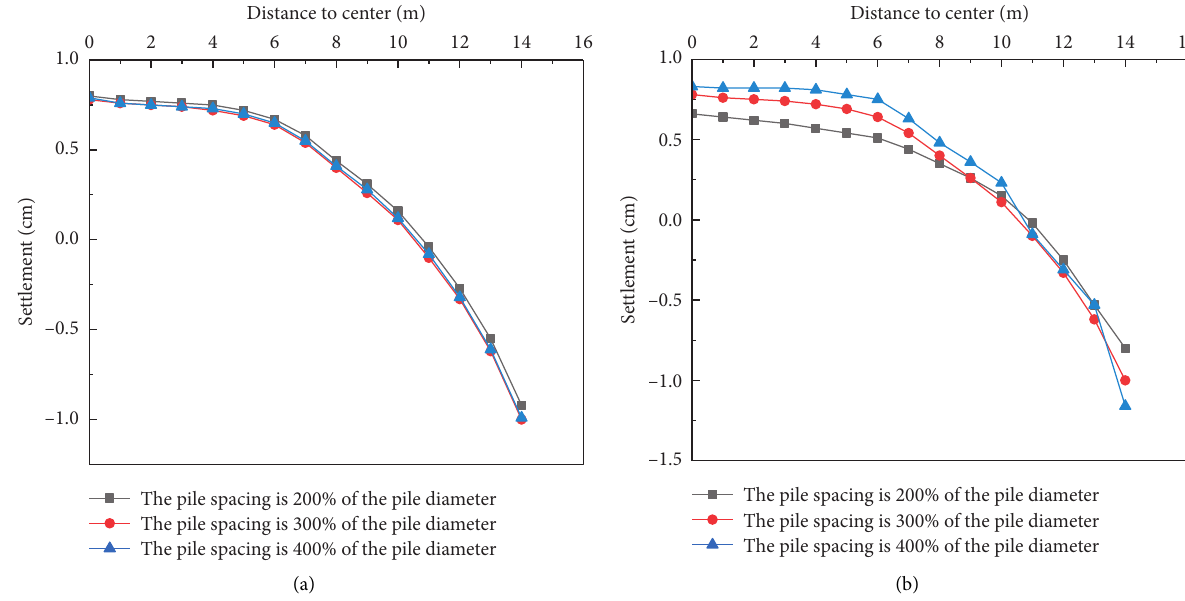
Figure 6: Completion settlement diagram of the old subgrade surface under different piles spacings. (a) Varying pile spacing under the existing road slope. (b) Varying pile spacing under the existing subgrade and new embankment.